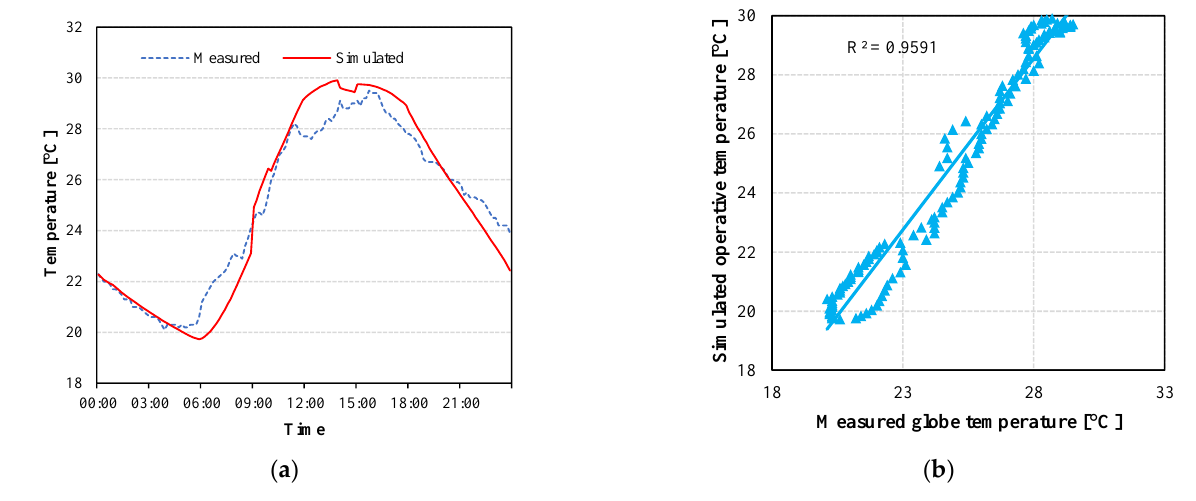
Figure 11. Validation of the base model: ( a ) variation ( b ) relationship between the measured globe and simulated operative temperatures on 4 June 2019. A few other studies [67,92] used measured indoor air temperature and simulated operative temperature to validate models.